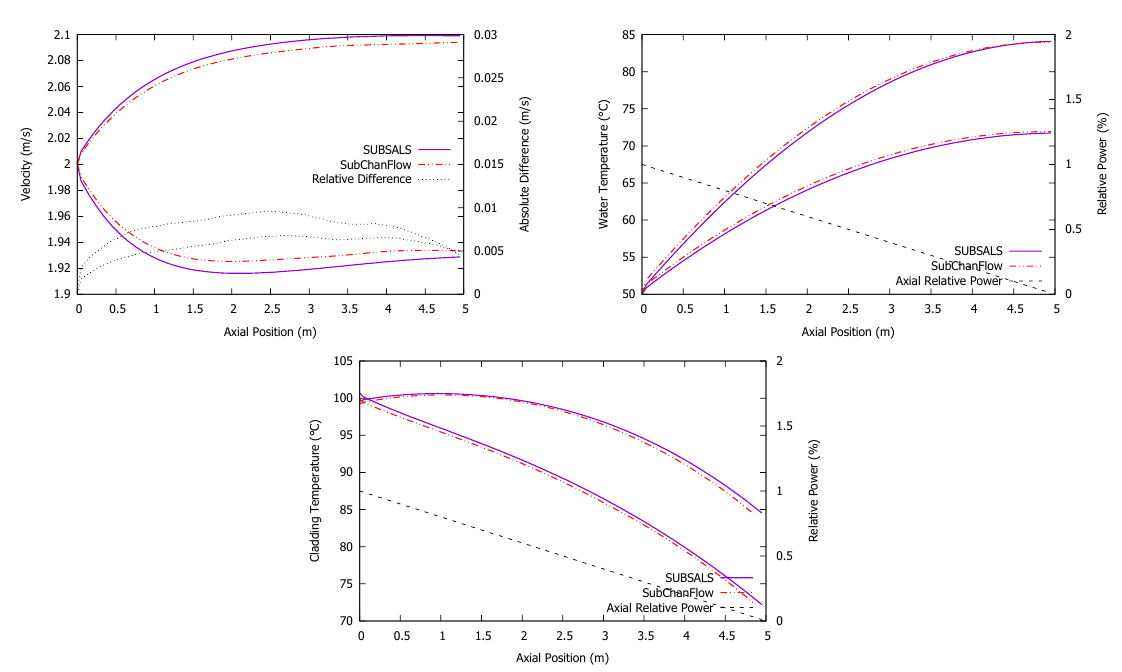
Figure 8. Comparison of axial velocity (top left), water temperature (top right) and cladding temperature (bottom) distribution calculations with linearly decreasing axial power distribution.